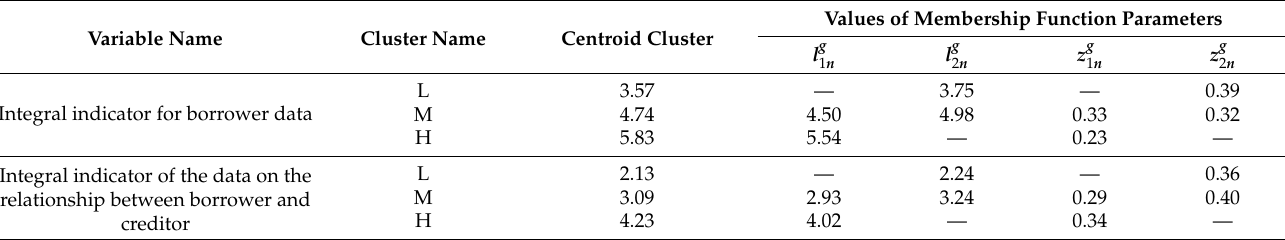
Table 3. Parameters of clusters and parameters of membership functions of integrated indicators based on the results of their neural processing.